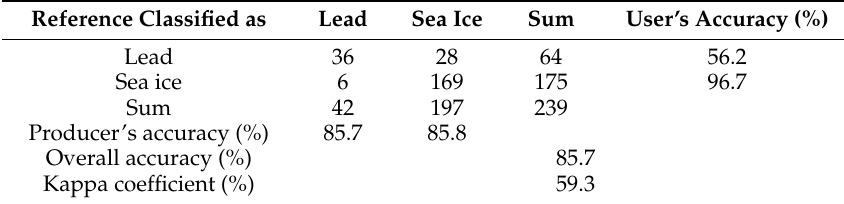
Table 9. The error matrix based on the lead detection results by the approach of Rose [16].